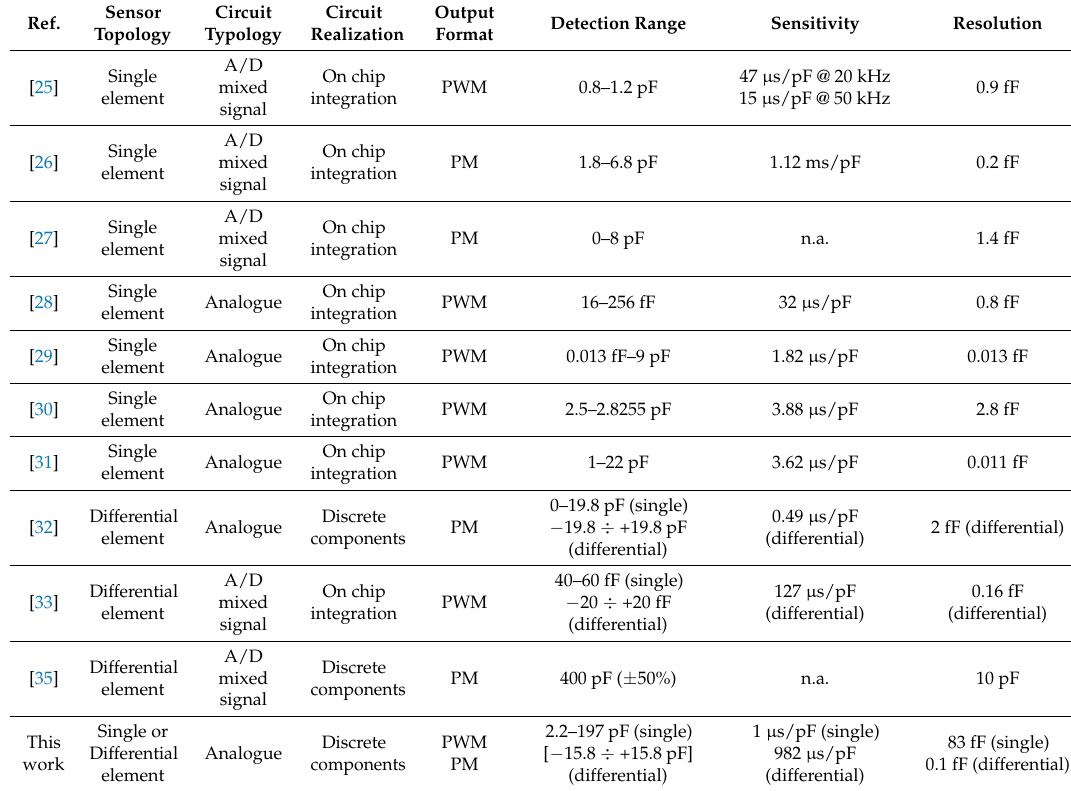
Table 1. Main performance parameters of the proposed circuit as compared to other similar solutions based on C - T